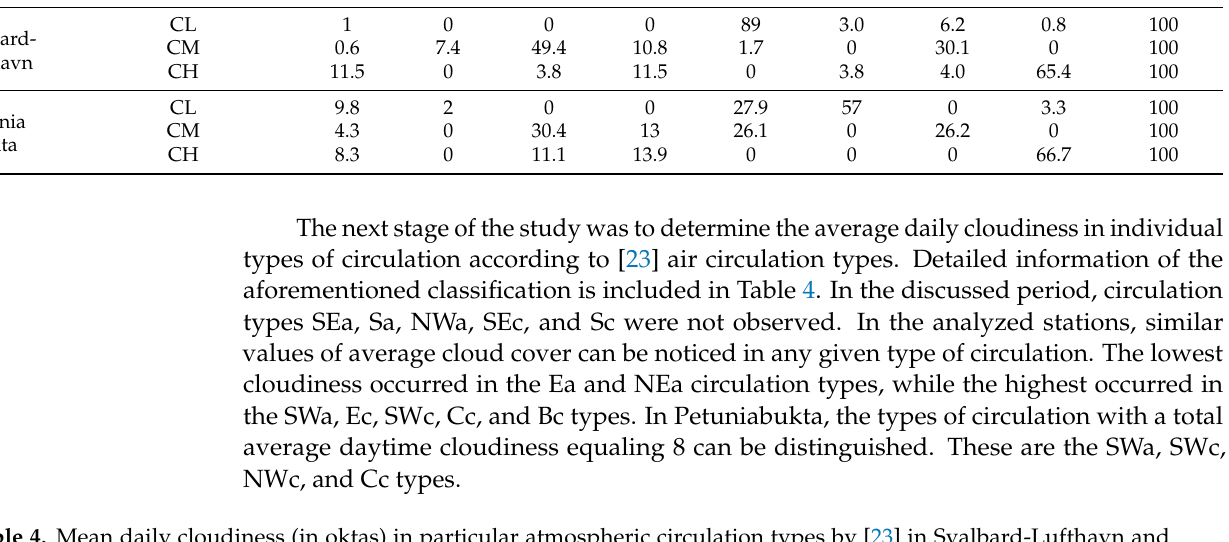
Figure 3. The daily amount of cloudiness in Longyearbyen (Svalbard-Lufthavn) ( A ) and Petuniabukta ( B ) and the difference between Petuniabukta and Svalbard-Lufthavn ( C ) during the period from 9 July to 30 August 2016. The frequency levels of clouds divided into groups according to the SYNOP code are Table 3. Percentage of cloud types in Petuniabukta and Svalbard-Lufthavn during the period from 9 July to 30 August 2016. presented in Table 3. In the analyzed stations, differences in the number of reported types Level of clouds: CL—low, CM—medium, CH—high. of clouds can be noticed. In Petuniabukta, Stratus nebulosus (St neb) (SYNOP CL6 key) was more often observed than in Svalbard-Lufthavn. In turn, a lower frequency of Strat- ocumulus (Sc) clouds (SYNOP CL5 key) was observed in Petuniabukta. Noteworthy is also the reports of lower amounts of medium cloud level in Petuniabukta. However, it